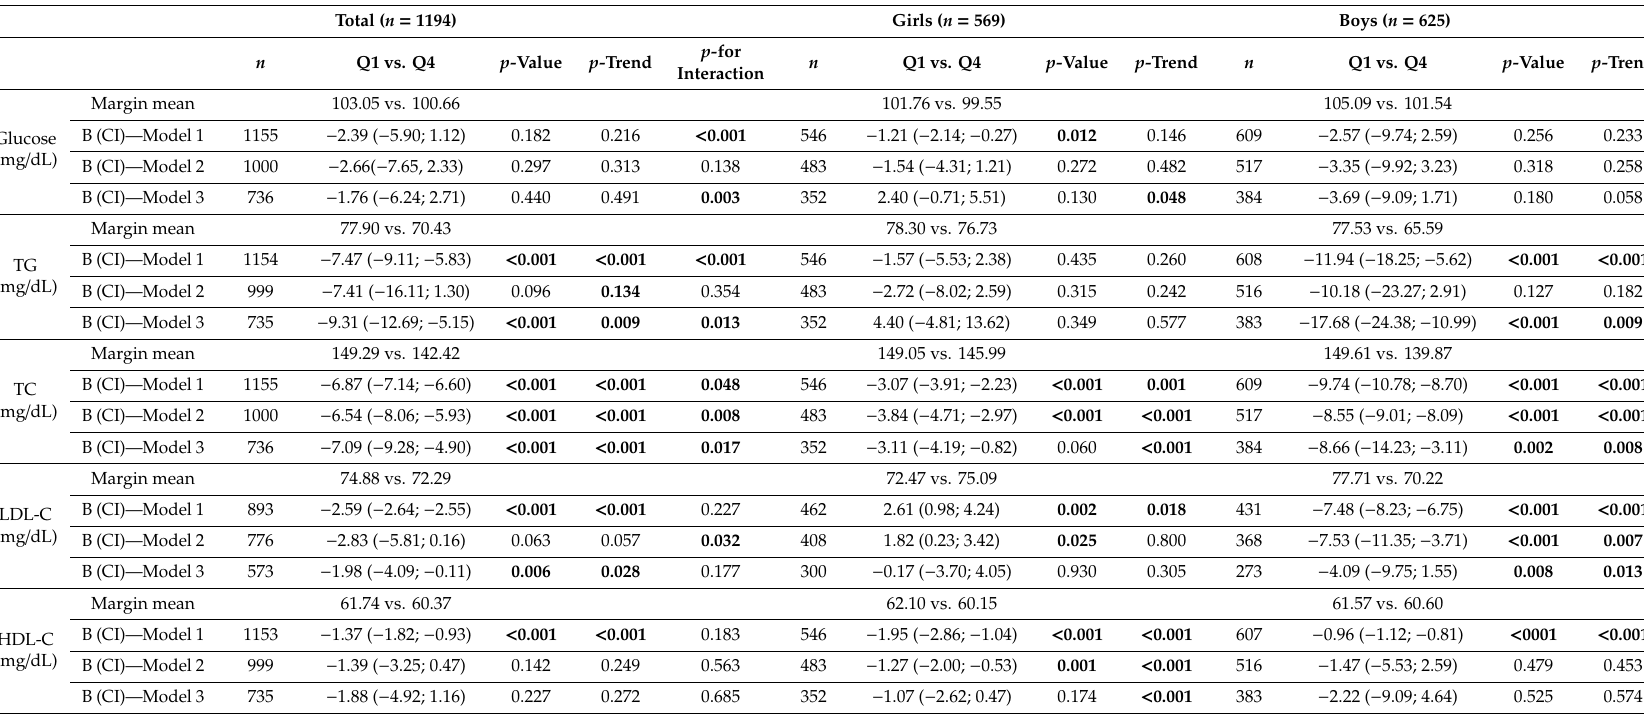
Table 5. Association between blood analytes of cardiovascular health and quartiles of TPE (mg GAE / g creatinine), according to